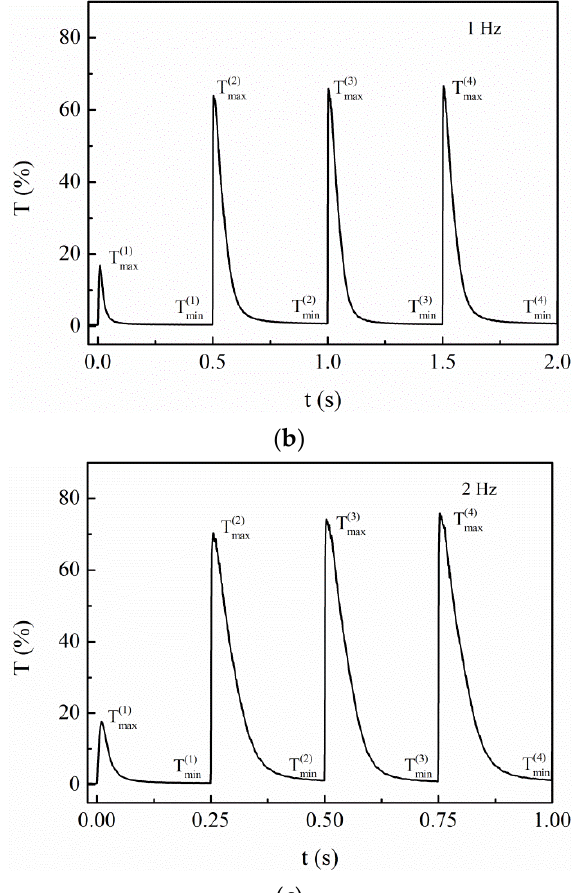
Figure 5. The T-t curves of the PDLC film by applying an AC square wave voltage at the frequencies of 500 mHz, 1 Hz, and 2 Hz, respectively. 𝑇